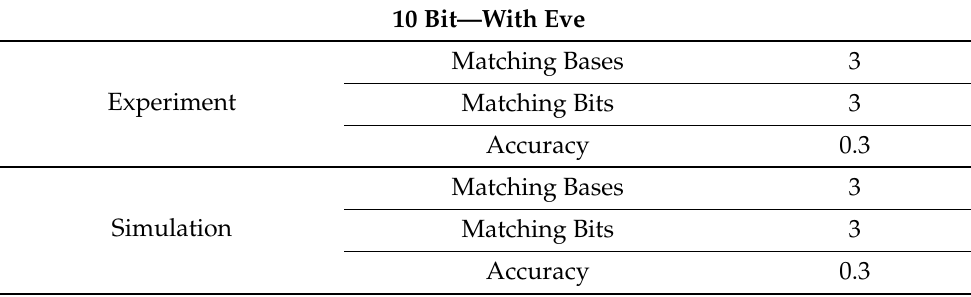
Table 5. A 10 bit accuracy for experiment and simulation—with Eve.